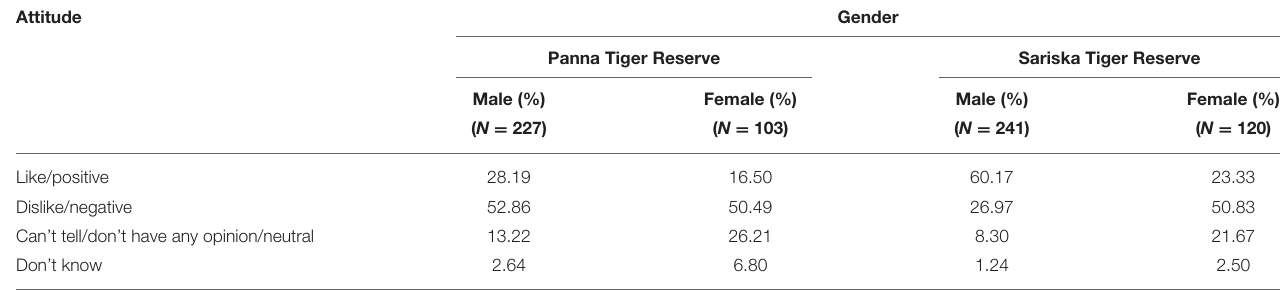
TABLE 2 | Gender-wise attitude of local communities towards tigers in Panna and Sariska Tiger Reserve. Attitude